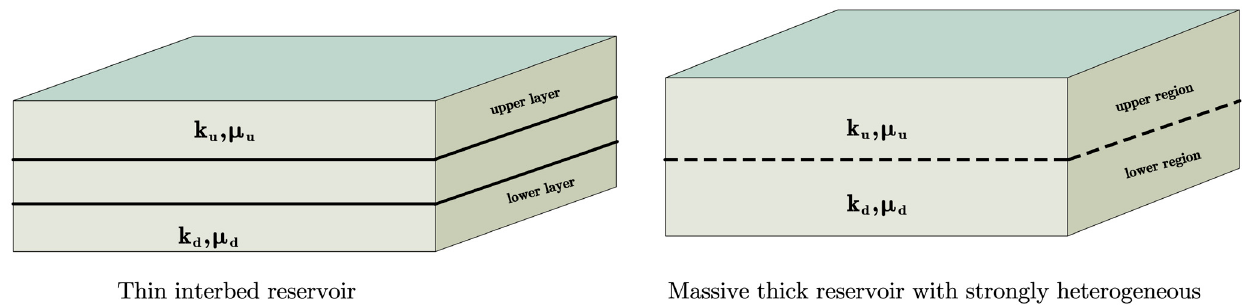
Figure 12. Two simpli fi ed reservoir characteristics and corresponding parameters.